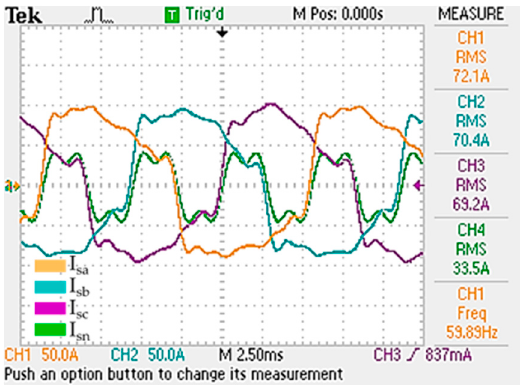
Figure 10. Source current of ES1 scenario. Current scale is configured to 50 A/div and time scale is configured to 2.50 ms.